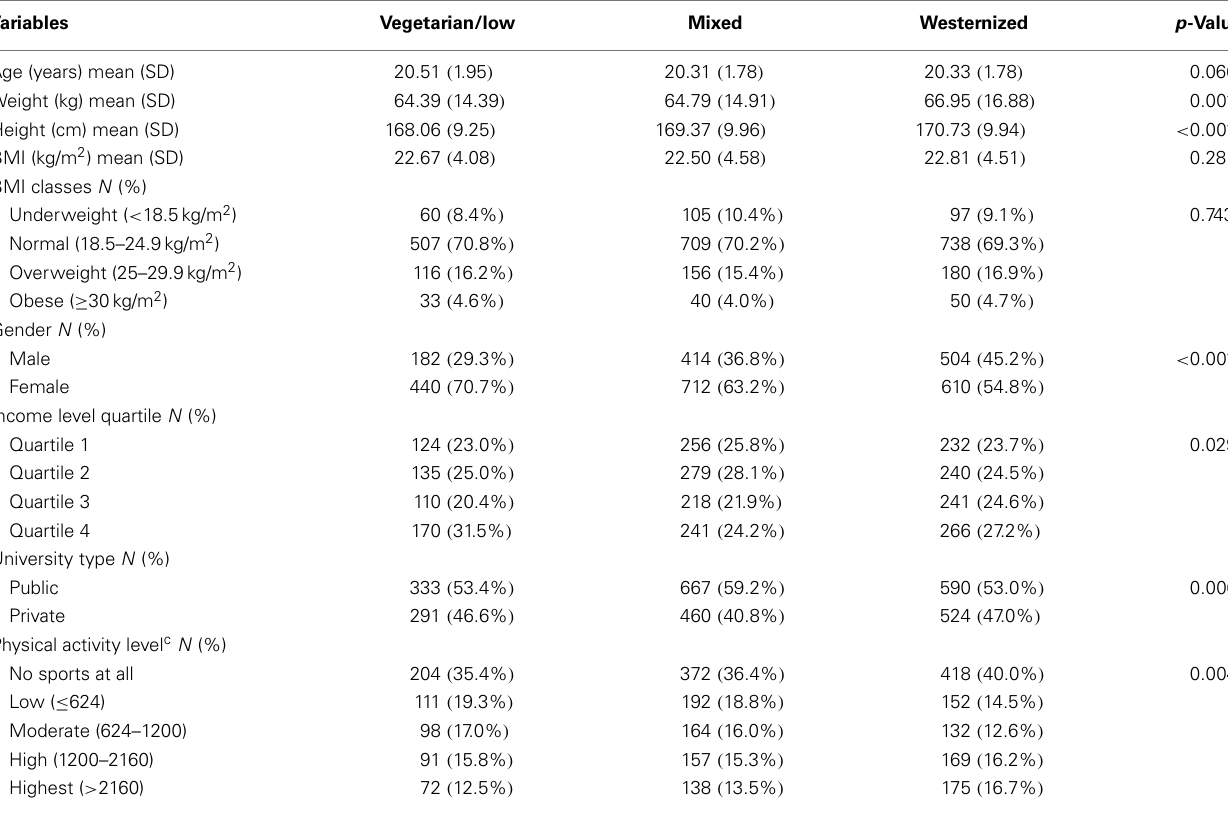
Table 5 | Characteristics of university students in the study sample according to the three identified dietary patterns .